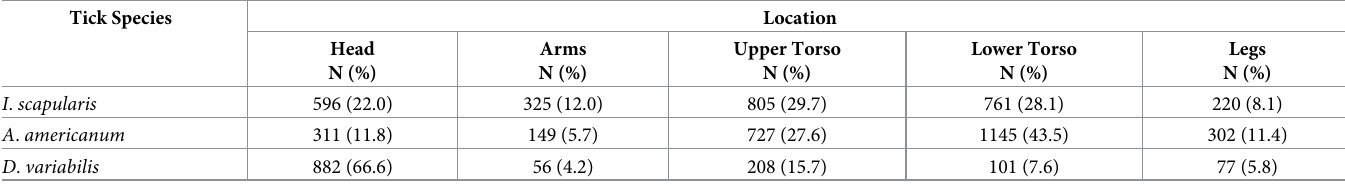
Table 3. Reported location of attachment on human hosts.